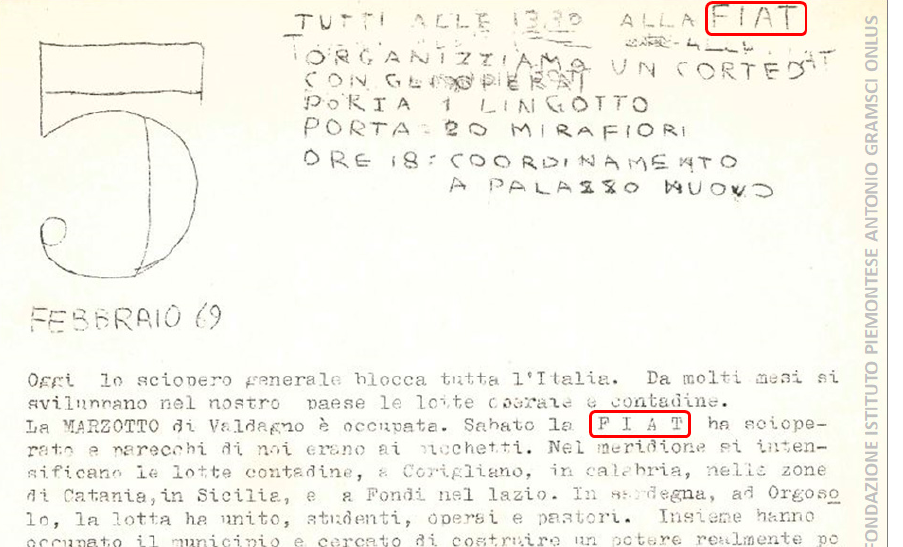
Figure 1. A document from the archives of the Gramsci Institute, talking about the FIAT company (Copyright: Fondazione Istituto piemontese Antonio Gramsci onlus).